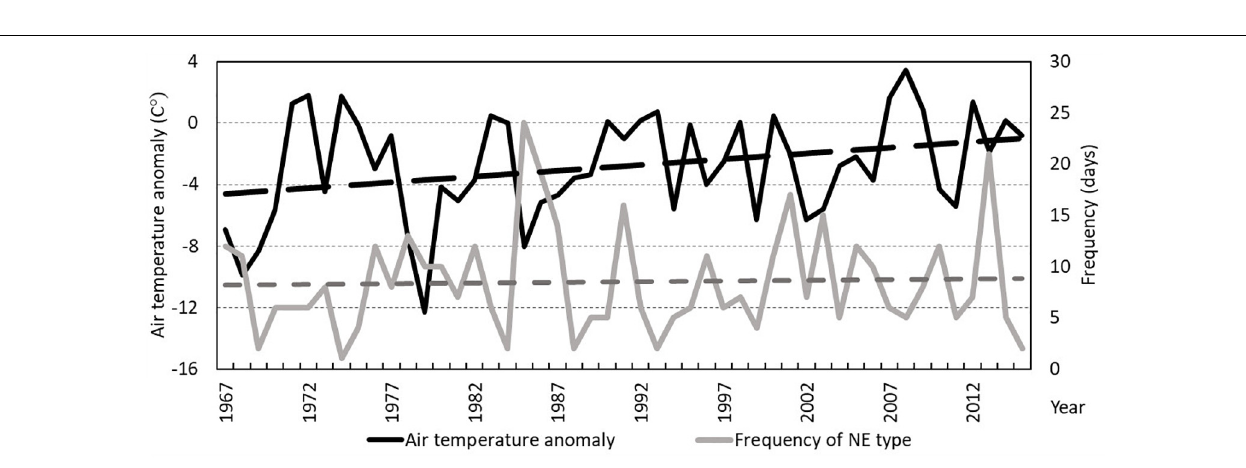
Frontiers in Earth Science |